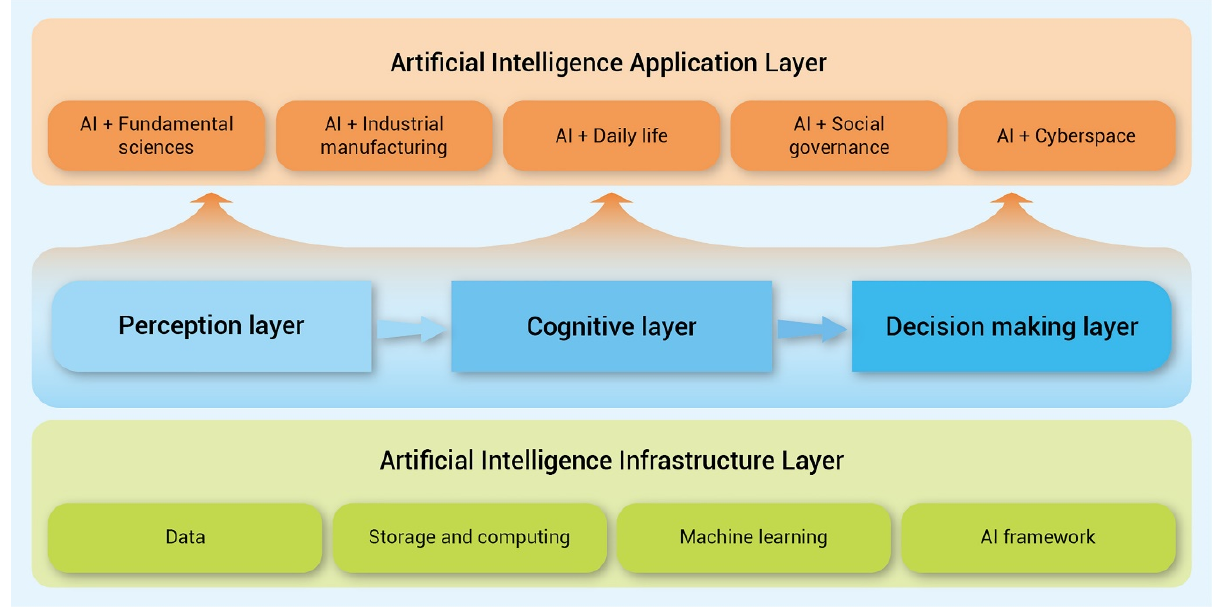
Figure 5. The general framework of artificial intelligence [69].